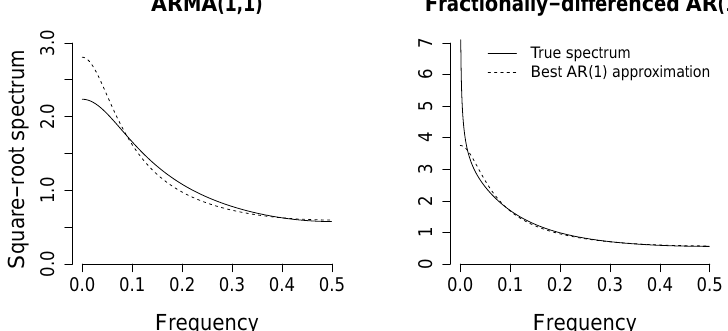
Figure 8. The power spectra associated with the two models from which we generate synthetic time series in Sect. 5.2, along with spectra of the best AR(1) approximations (in Kullback–Leibler divergence) to both models; see Table S2 for noise model parameters. The corresponding illustrations of the performance of the various time series methods are shown in Figs. 9 and 10. The AR(1) model will tend to overestimate low-frequency variability in the first case and underestimate it in the